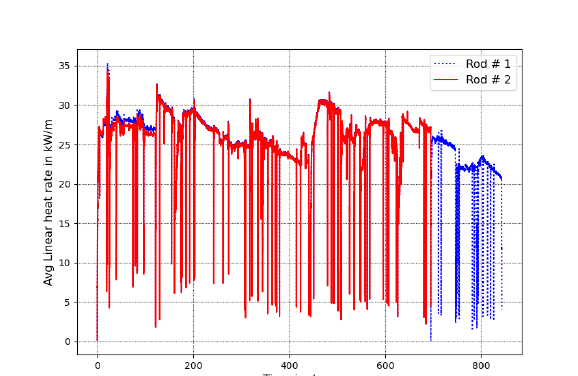
Figure 3. IFA 716 average linear heat rate measured during the